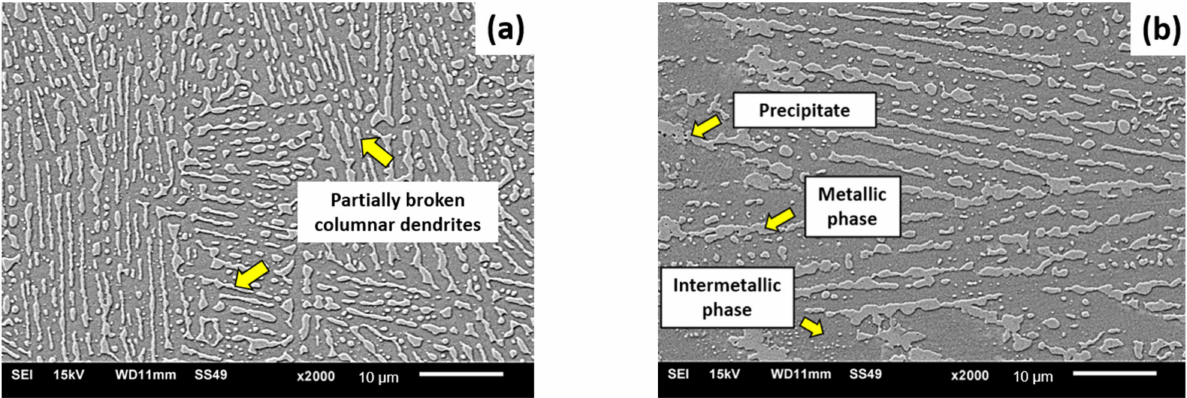
Figure 11. Microstructure of case 4 under ( a ) SEM-BSE on the transverse plane, and ( b ) SEM-BSE on the sagittal plane.